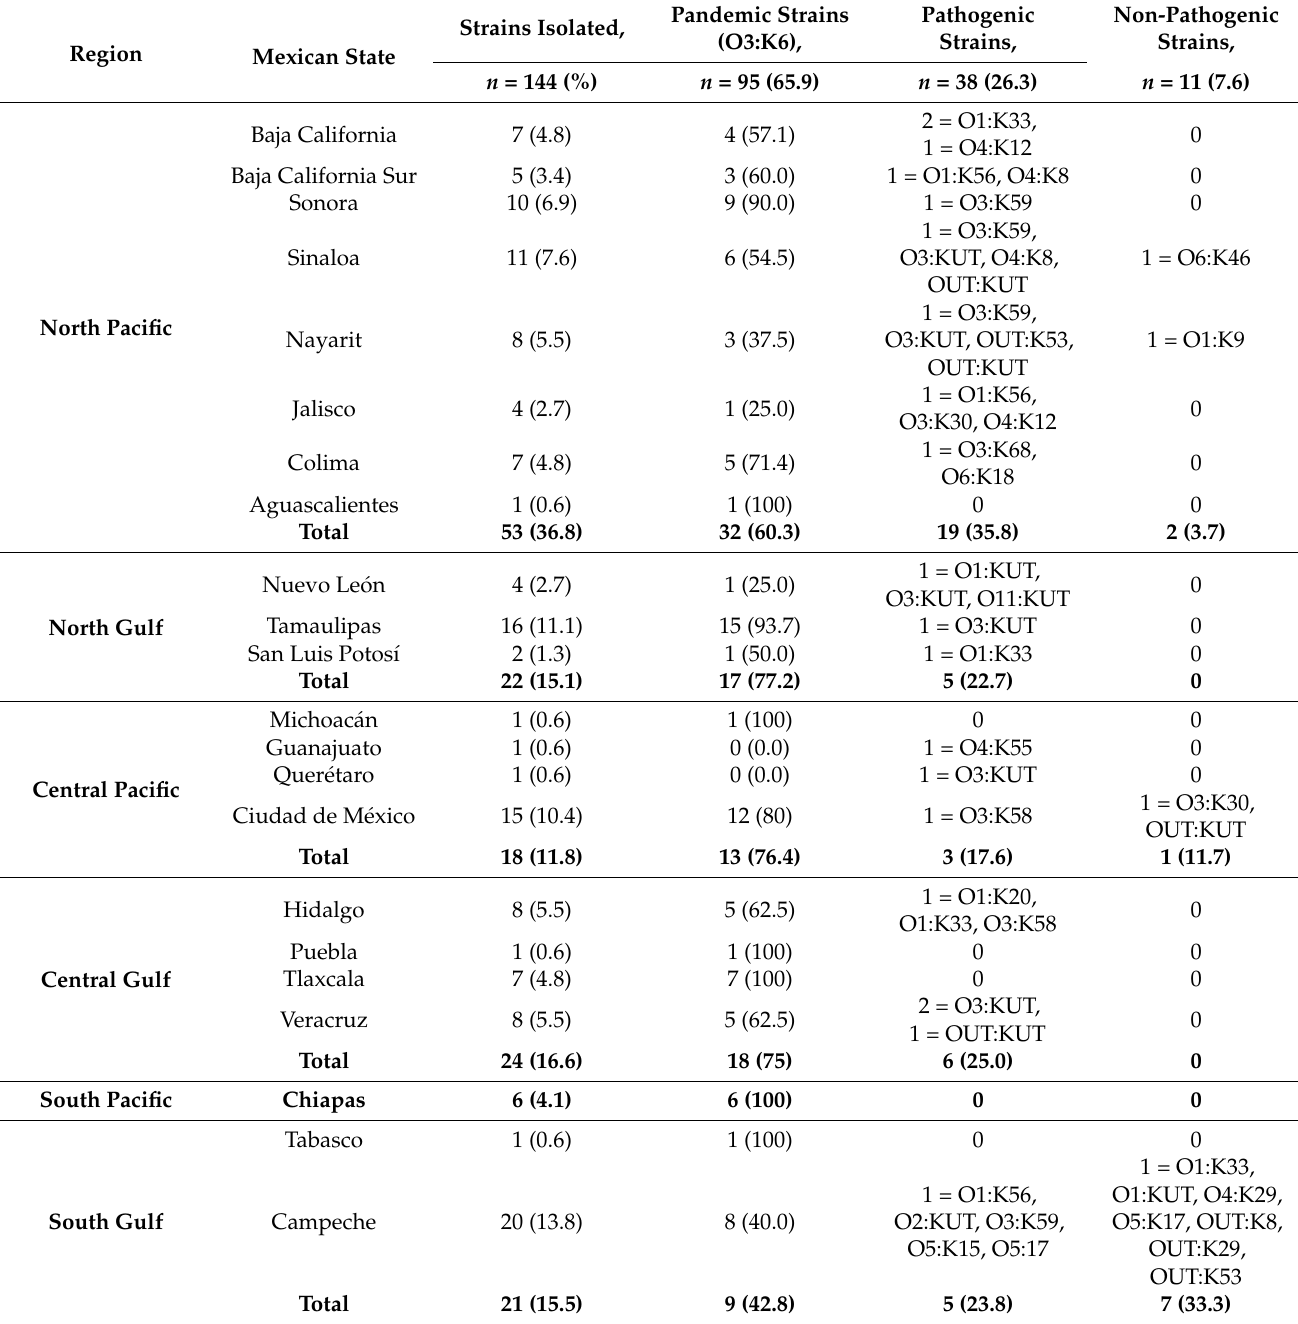
Table 4. Geographical distributions of Vibrio parahaemolyticus by serotype in Mexico, from 2004 to 2011.